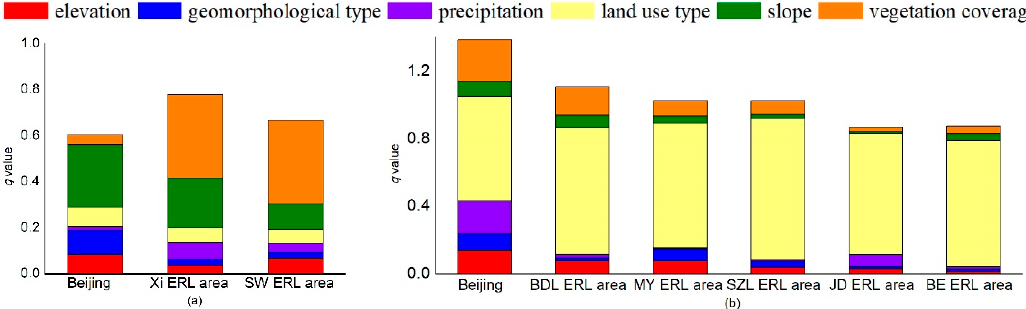
Figure 3. Statistics of q value affecting soil erosion ( a ) and water yield ( b ) in Beijing and ERL